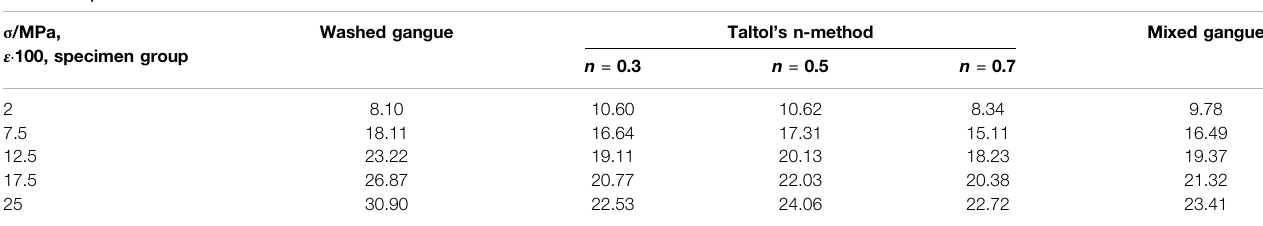
TABLE 11 | Stress – strain